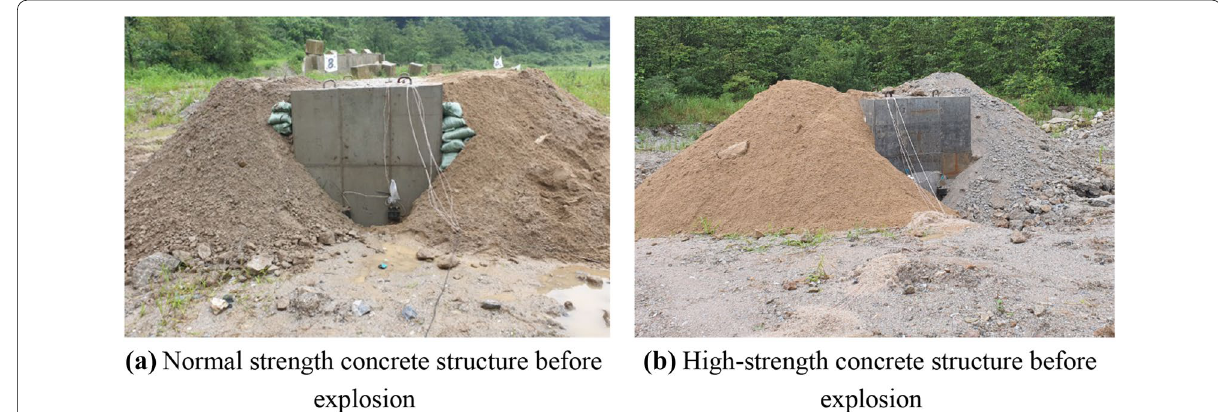
Fig. 11 After installation of experimental reinforced concrete structures.